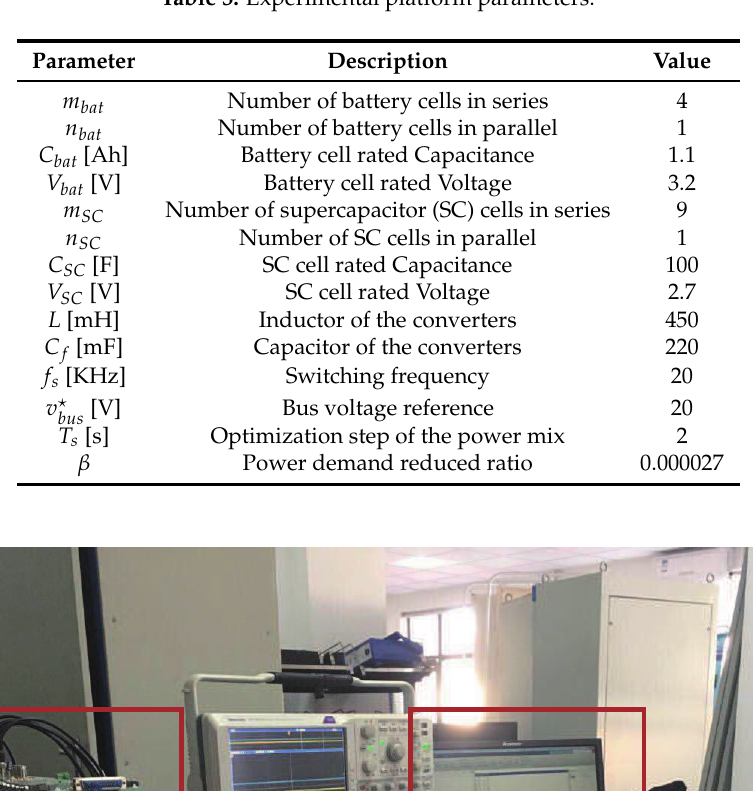
Table 3. Experimental platform parameters.